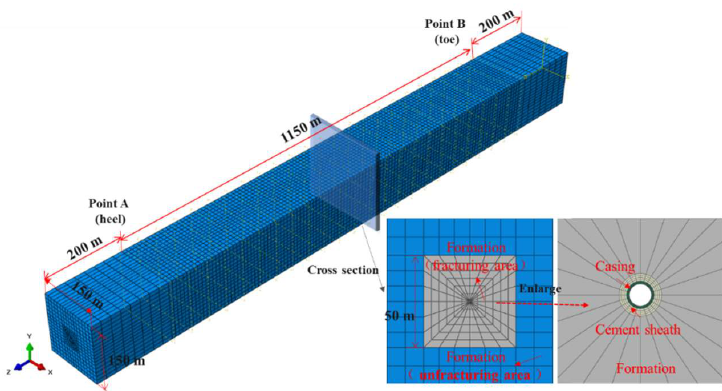
Figure 5. Calculation model of axial formation displacement.